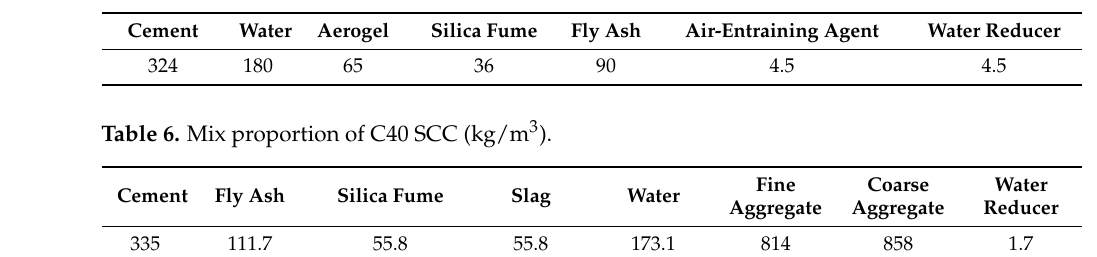
Table 5. Mix proportion of ACP (kg/m 3 ).